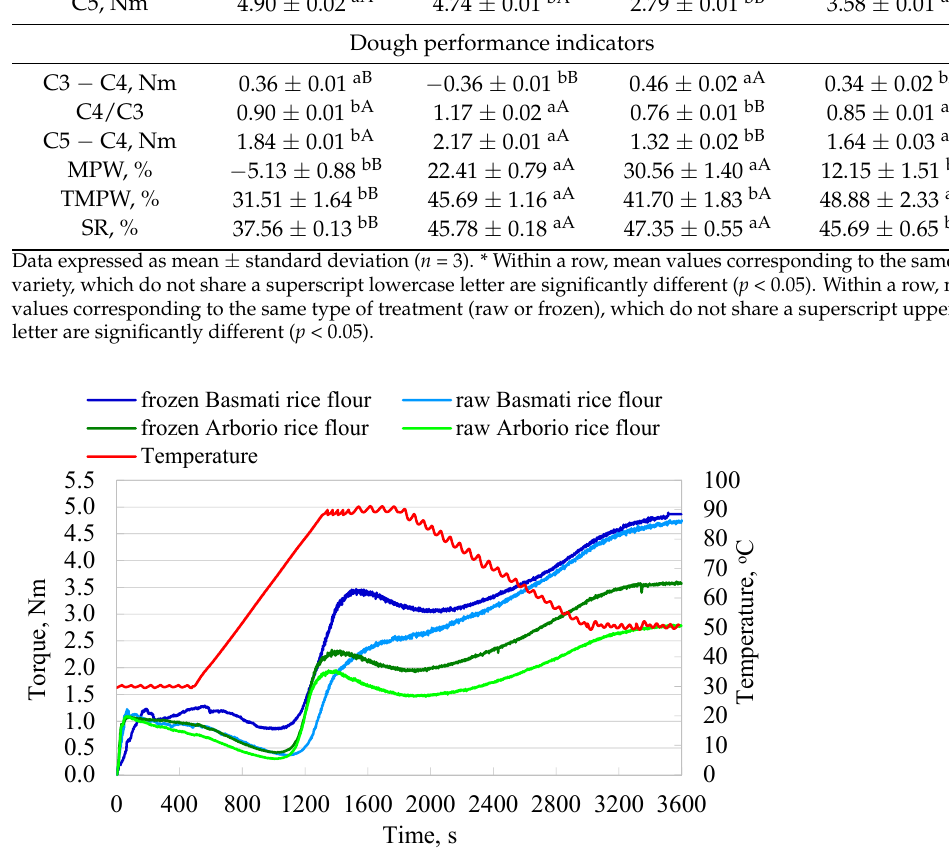
Figure 1. Mixolab curves of flours from raw and frozen Basmati and Arborio rice.